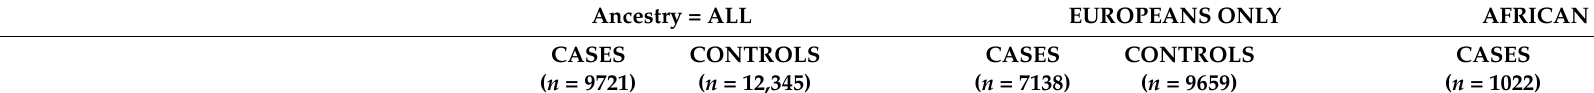
Table 4. Allele frequencies and counts of 15 EWA stroke-associated SNPs in cases and controls stratified by